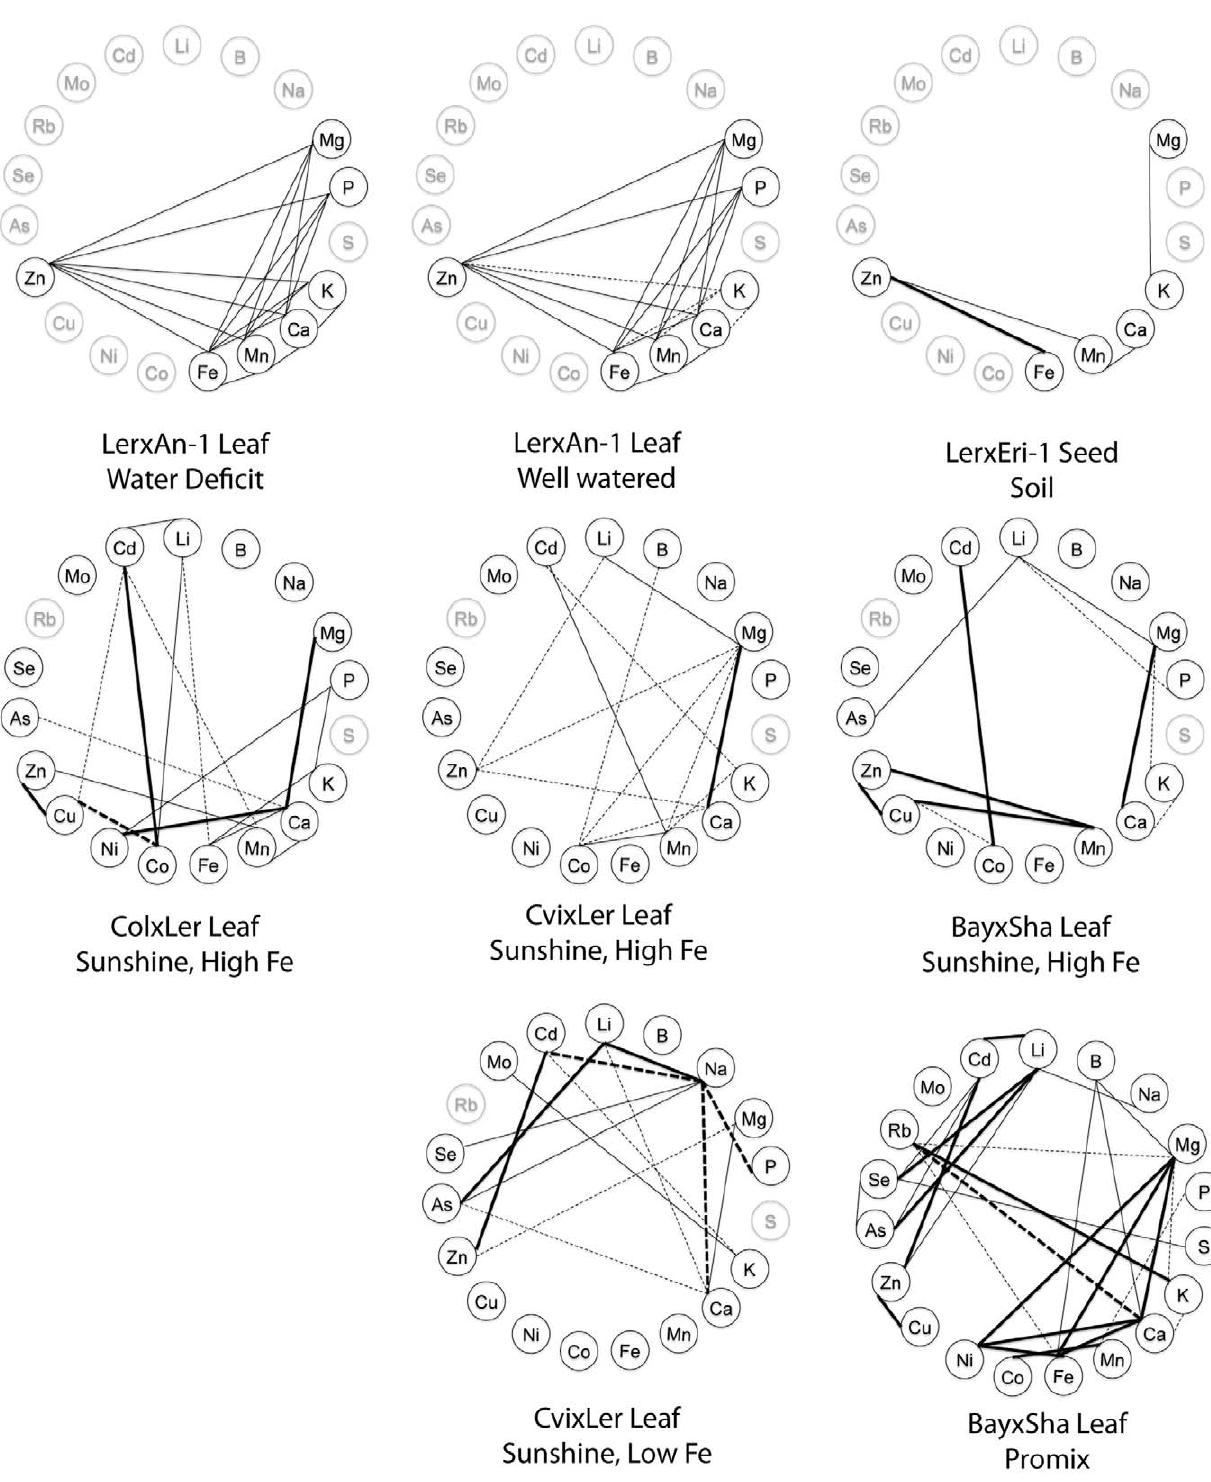
of genes in linkage with each other, making it less likely that a pair of correlated traits are being controlled by two unique but linked